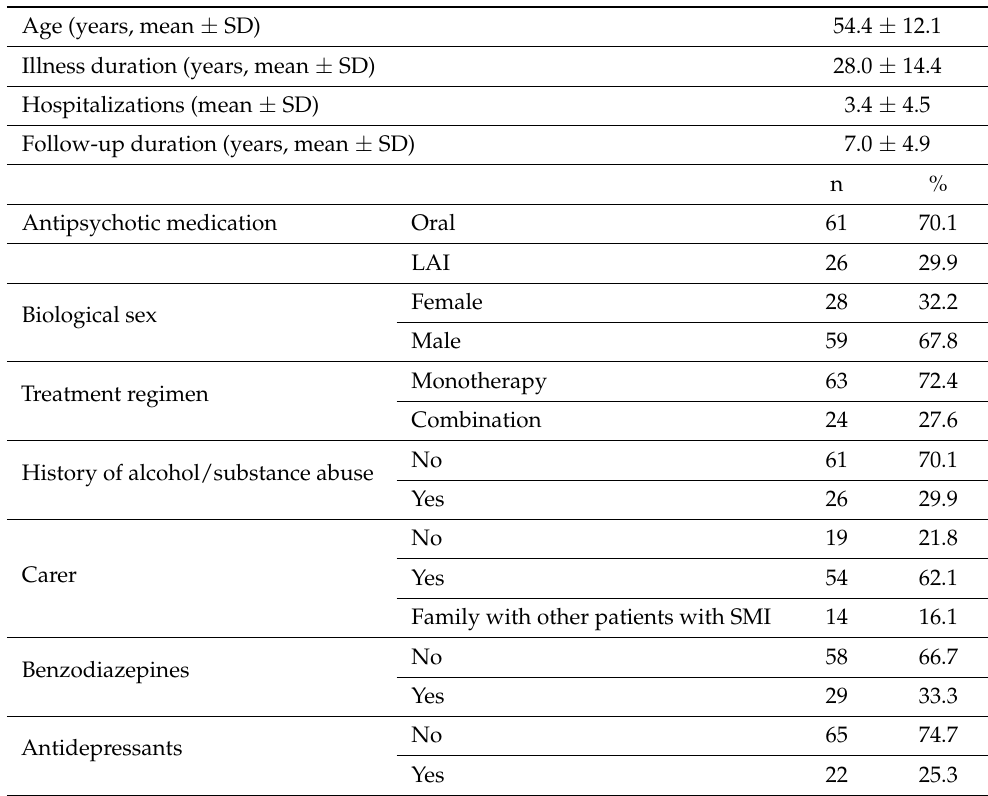
Table 1. Patients’ demographic and clinical